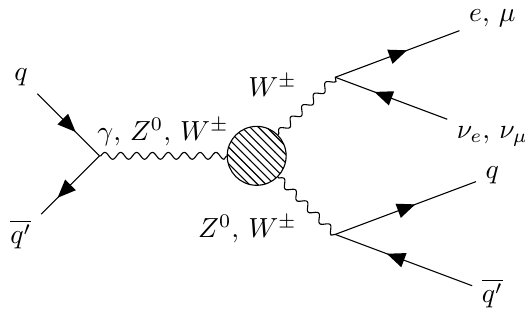
Figure 1 . The LO Feynman diagram for the diboson process involving triple gauge couplings studied in this analysis. One W boson decays to a lepton and a neutrino, and the other W = Z boson decays to a quark-antiquark